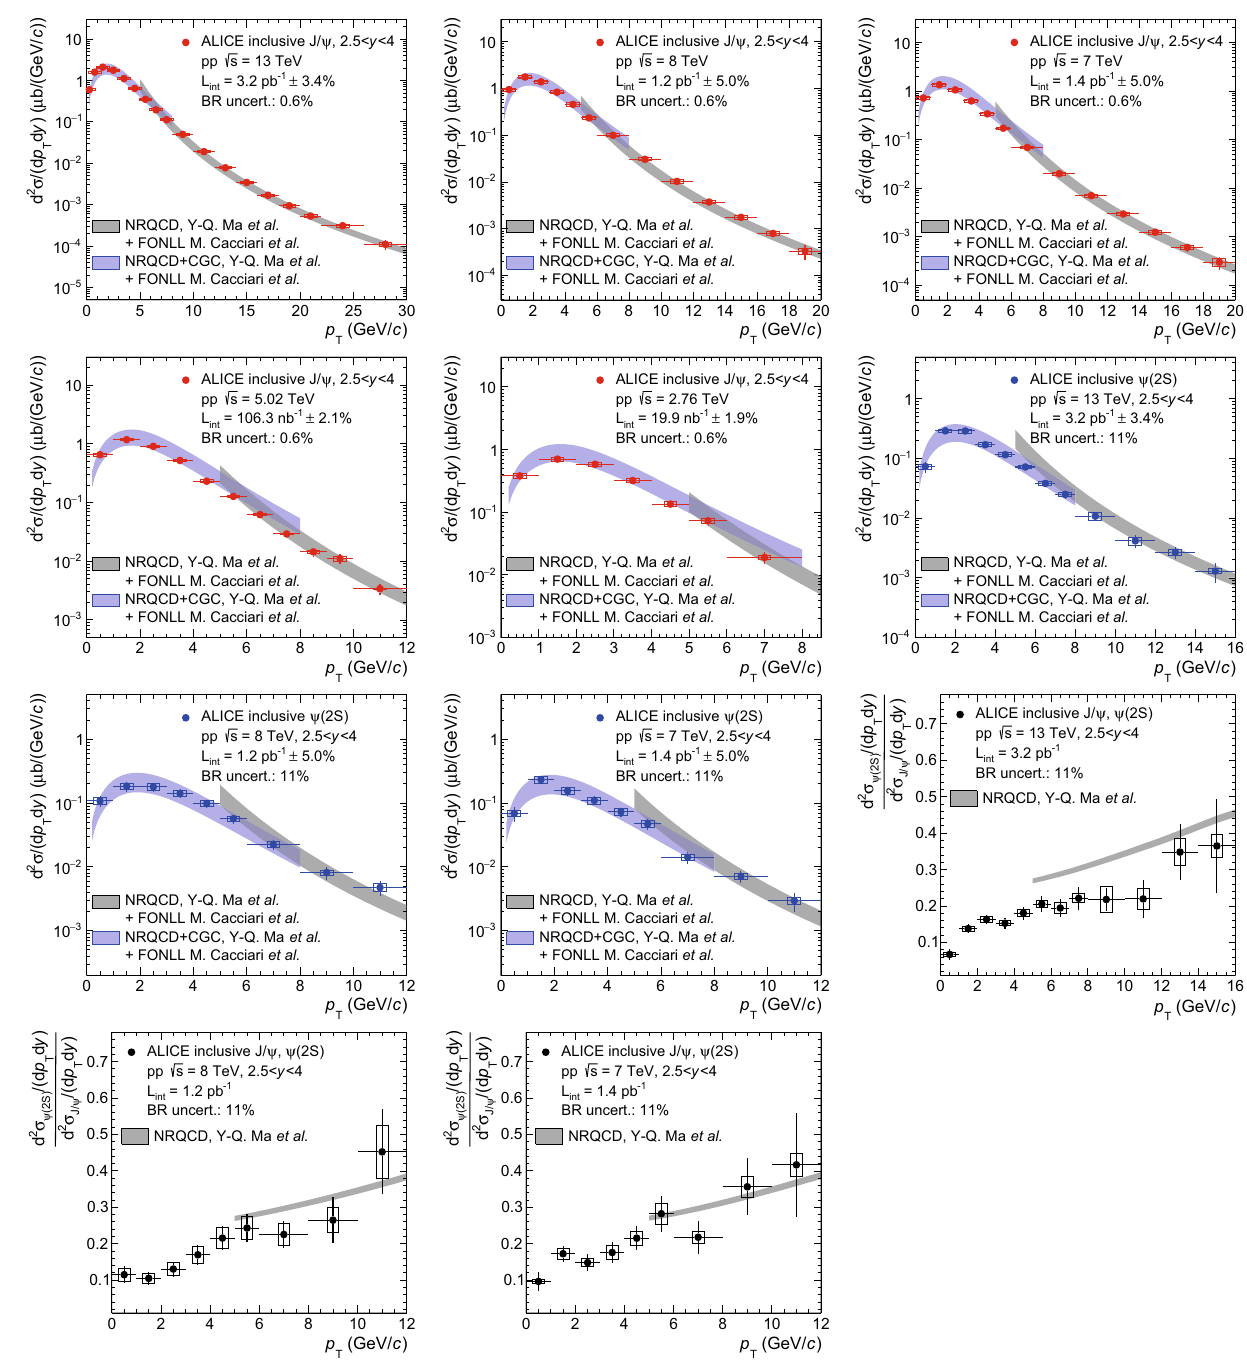
Fig. 8 ComparisonsbetweenALICEJ /ψ and ψ( 2S ) dataandsummed NRQCD and FONLL model calculations from [35–37]. The first five panels correspond to inclusive J /ψ production cross sections as a func- √ s = 13, 8, 7, 5 . 02 and2 . 76 TeV( red ), the tionof p t inpp collisionsat